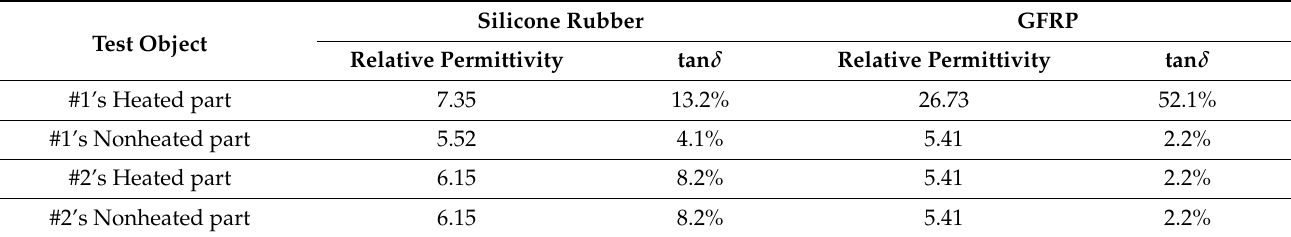
Table 3. Electrical parameters of composite